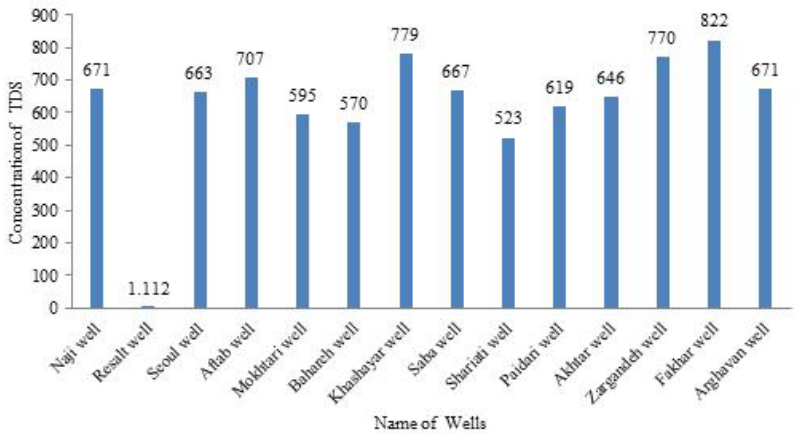
Fig. 6: Comparison of TDS value in the stations